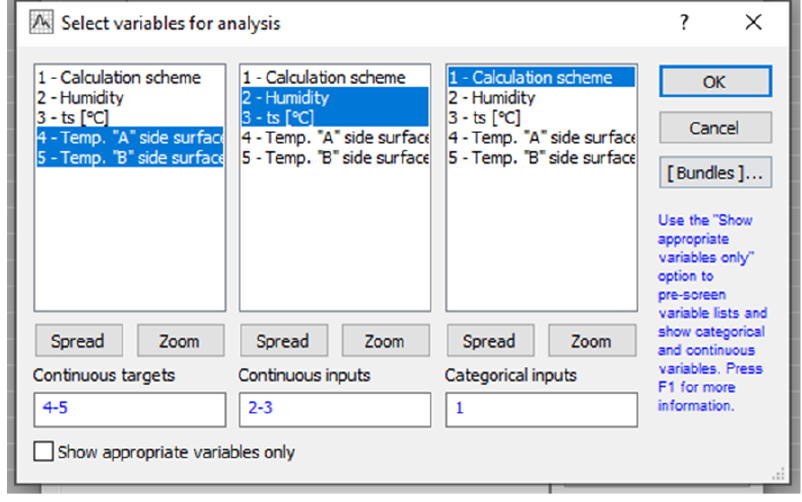
Figure 13. Matching the results of network runs to set input variables. Table 5. Sensitivity analysis.